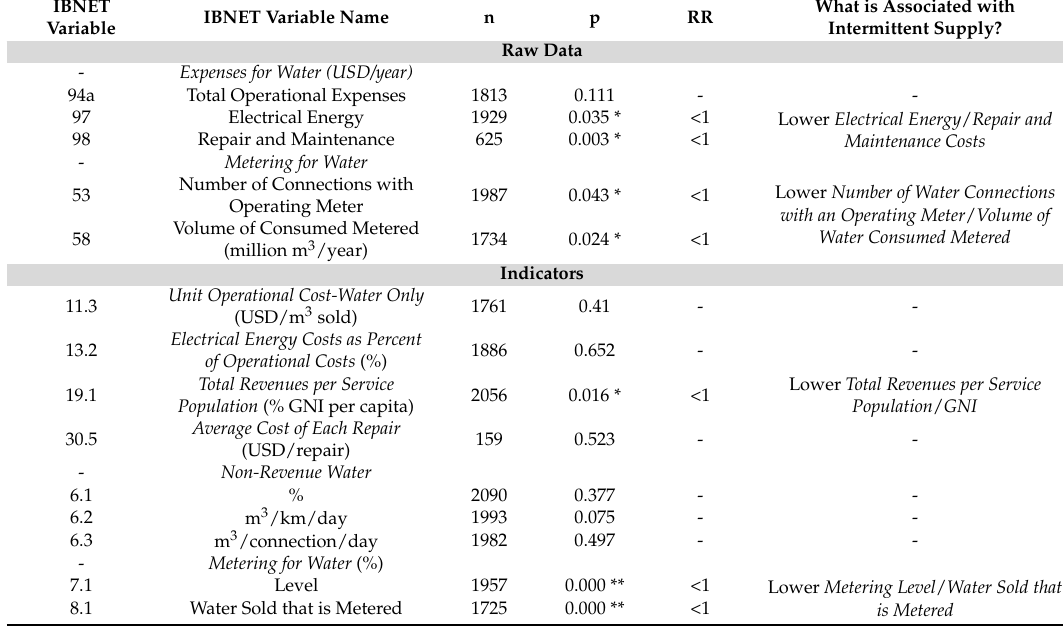
Table 5. A selection of variables related to finances, non-revenue water, and metering, and their relationship to intermittent (<24 h) vs. continuous (24 h) supply. Includes variable number and names as used in the IBNET database (ib-net.org), number of observations (n), the p value (p), the relative risk ratio (RR), and an interpretation of the